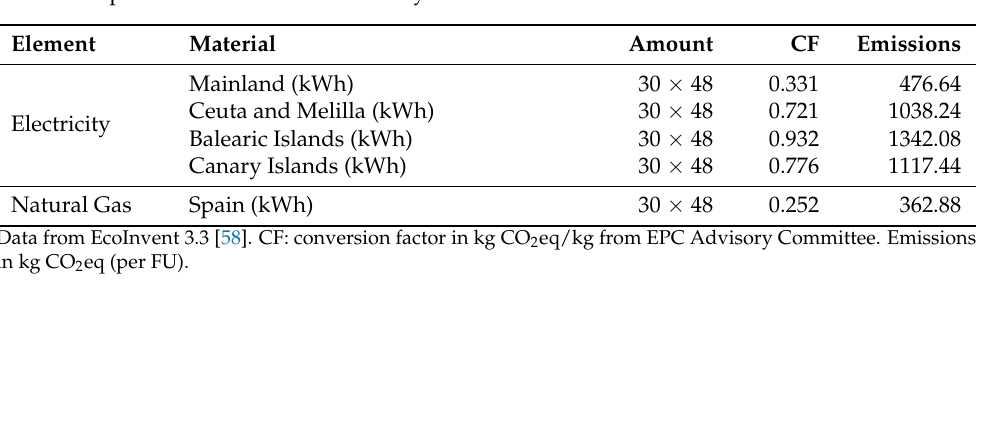
Table 11. Operational emissions from ST